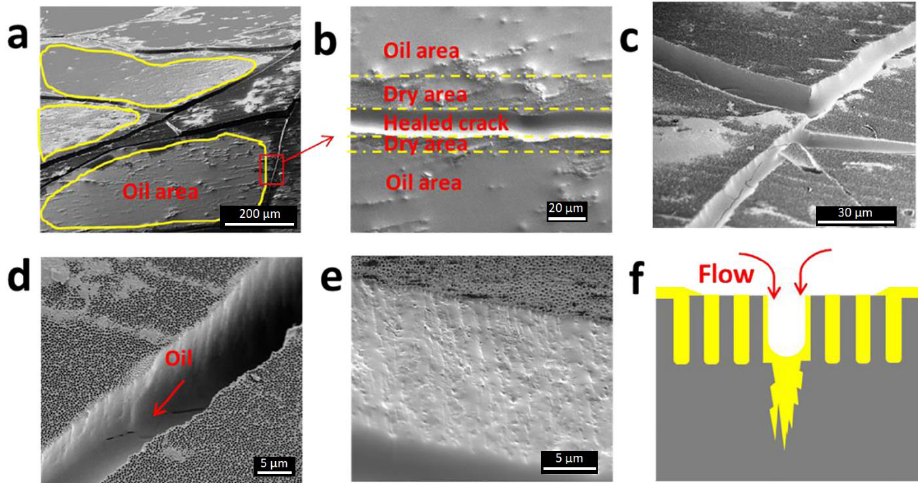
Figure 19. Cryo-SEM images of ( a – c ) generated micro-cracks, ( d ) surface surrounding the crack, ( e ) cross-section of lubricant filled crack, and ( f ) schematic of repair process. Reprinted with permission from [253]. Copyright 2019 Elsevier.